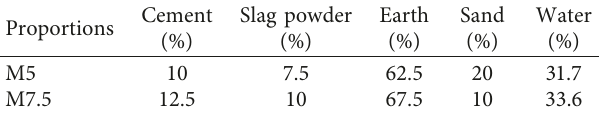
Table 1: The mixture proportions of two mortars.